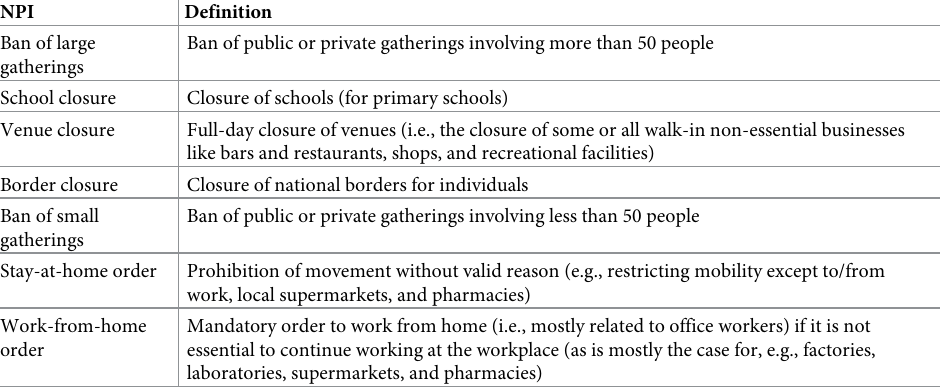
Table 1. List of non-pharmaceutical interventions